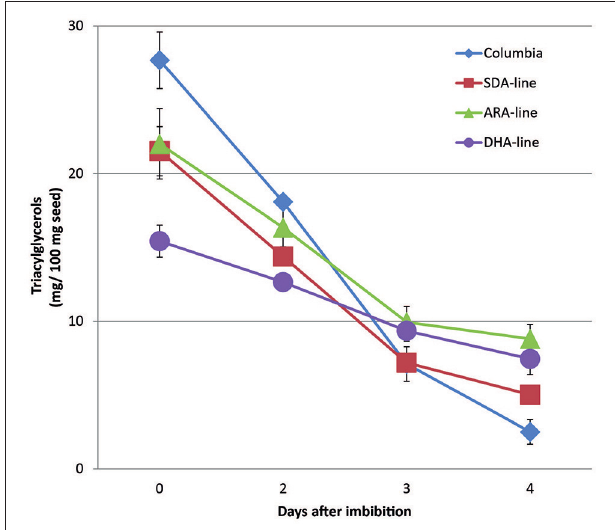
FIGURE 3 | TAG amount remained in seedlings per 100mg original seeds after imbibition. The error bars denote standard deviation from triplicates.